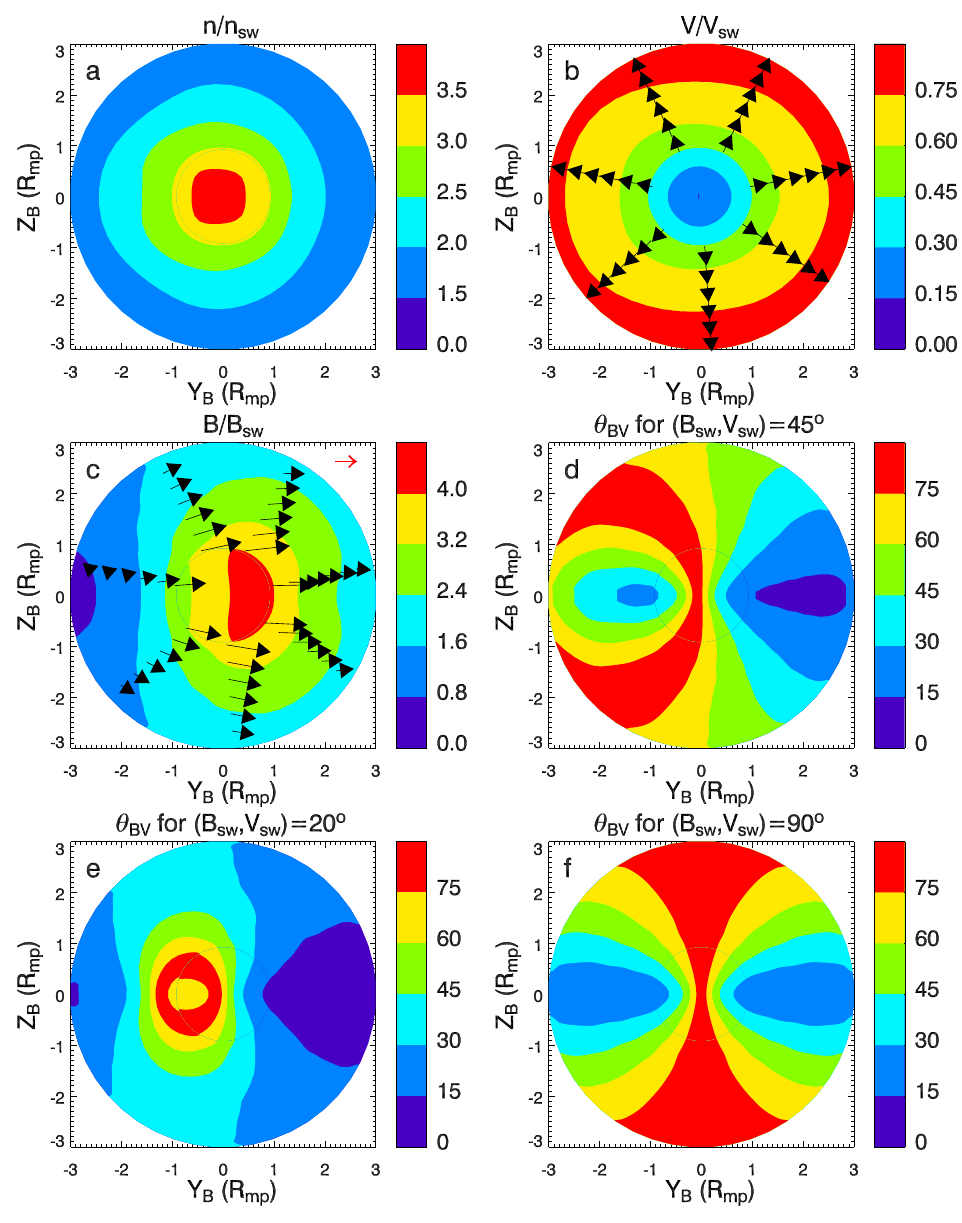
Figure6:Resultsof3DMHDsimulations.The(cid:29)owand(cid:28)eldvalues al ulatedin